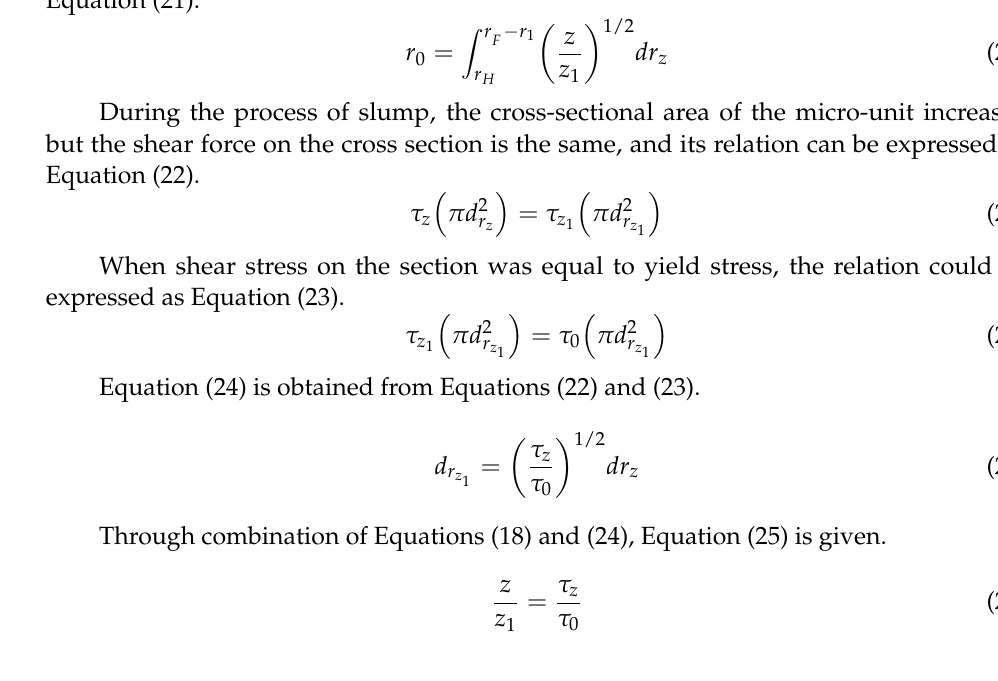
Through substitution of Equation (18) into Equation (20), r 0 can be expressed as Equation (21).